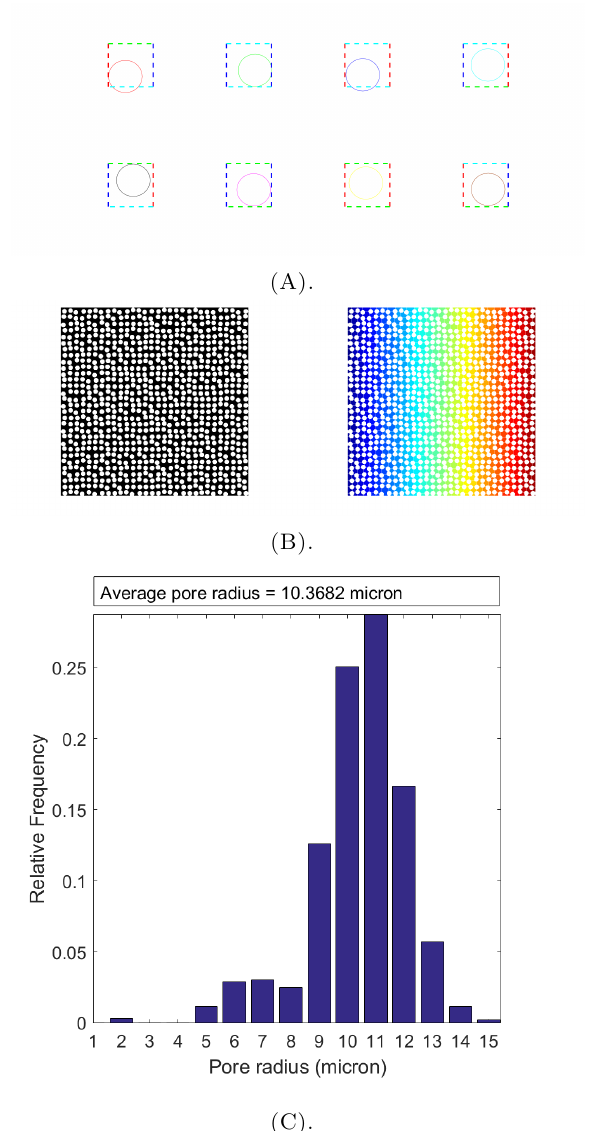
Figure 3. The first setings – (A) generated set, (B) tiling with pores, (C) pore size